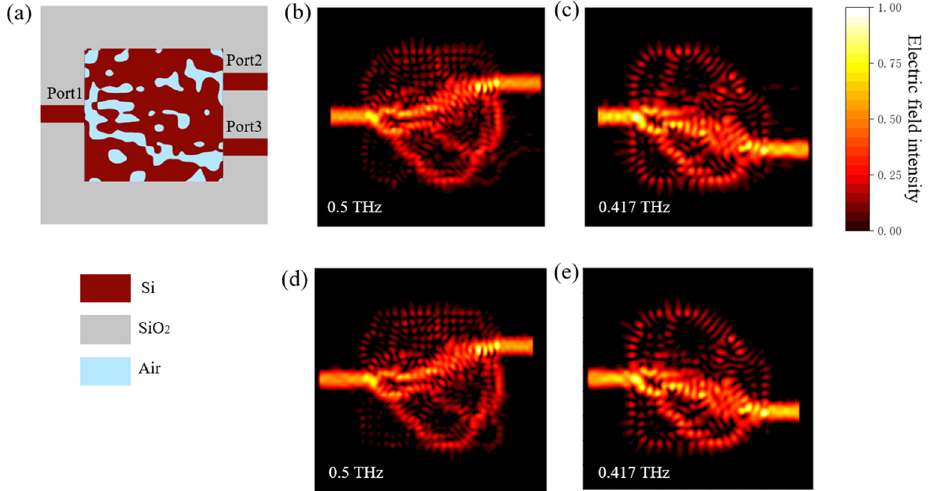
Figure 3. The top view of the final optimized structure diagram for the two-port THz demultiplexer ( a ) and the electric field intensity distribution maps at 0.5 THz ( b ) and 0.417 THz ( c ) when the mixing THz waves were incident from Port 1, at 0.5 THz when the THz wave were incident from Port 2 ( d ) and at 0.417 THz when the THz wave were incident from Port 3 ( e ), indicating that the device also worked as a multiplexer.